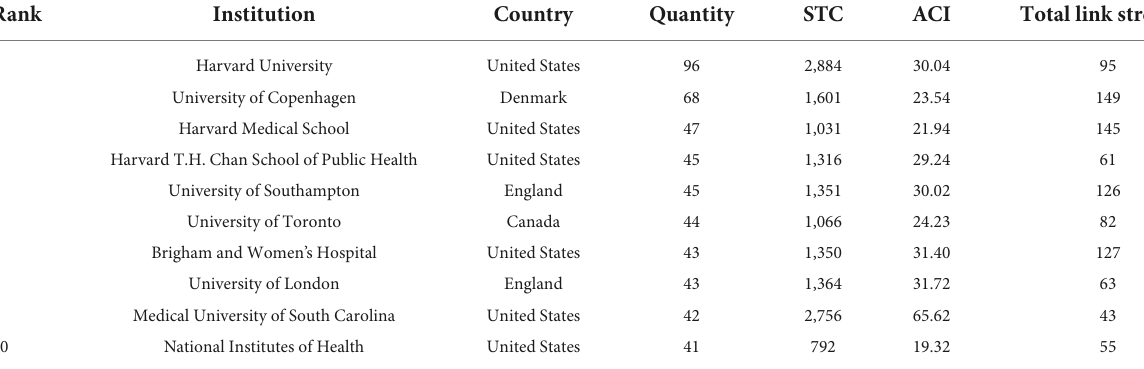
TABLE 2 Top 10 institutions in the studies of vitamin D and reproductive health.